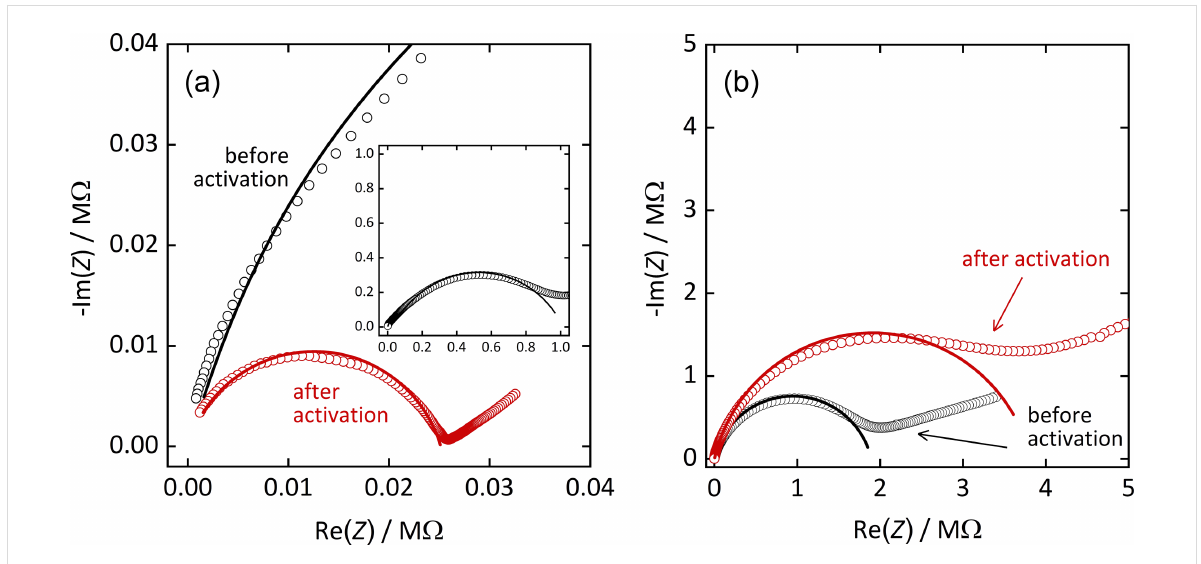
Figure 2: Nyquist plots (imaginary vs real part of impedance Z ) of (a) [Mg(H 2 O) 2 (H 3 L)]·H 2 O and (b) [Pb 2 (HL)]·H 2 O, before and after thermal activa- tion. Measurements were conducted at 22 °C and 90% r.h.; lines represent the fit results from using the equivalent circuits described in the text.